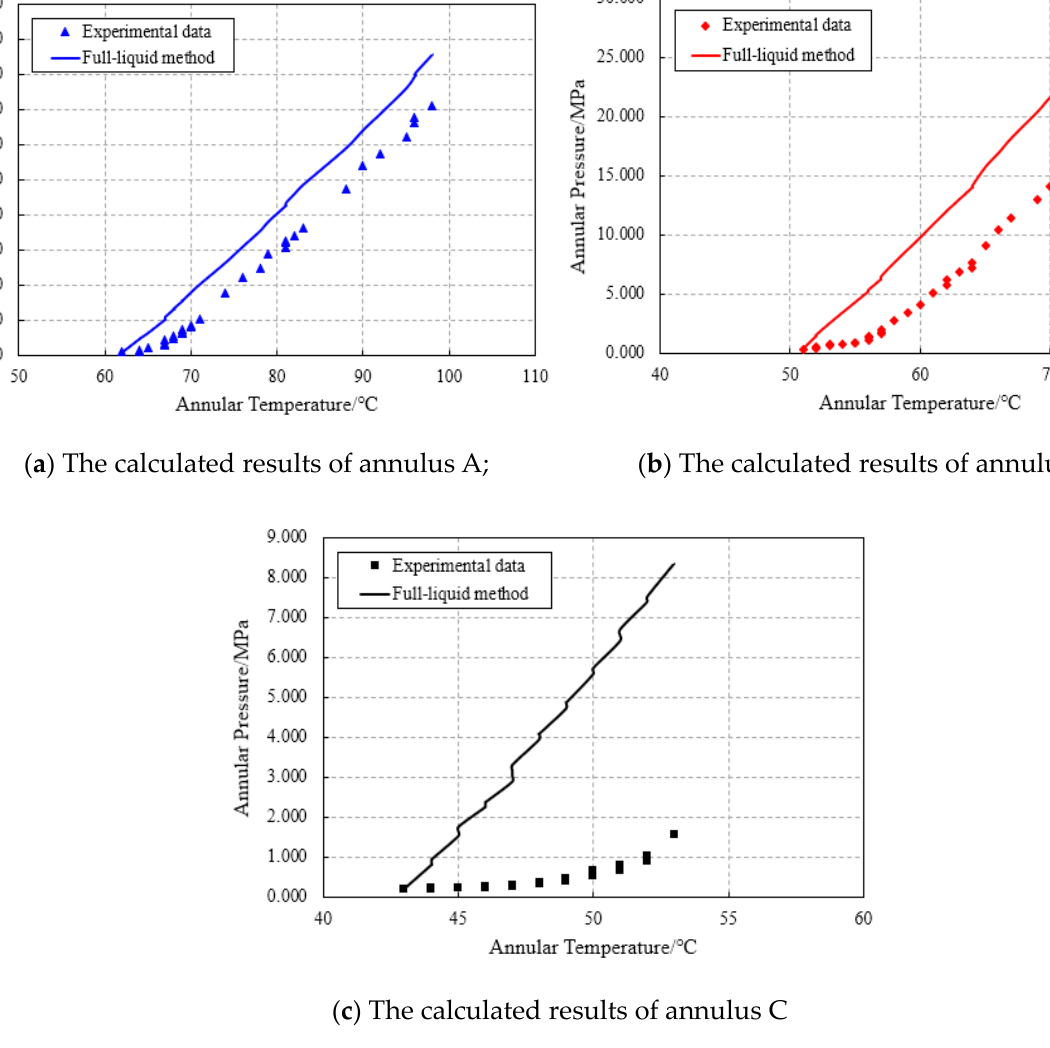
Figure 9. Comparison of the full-liquid model simulations with experimental data. The error analysis of the calculated results is shown in Table